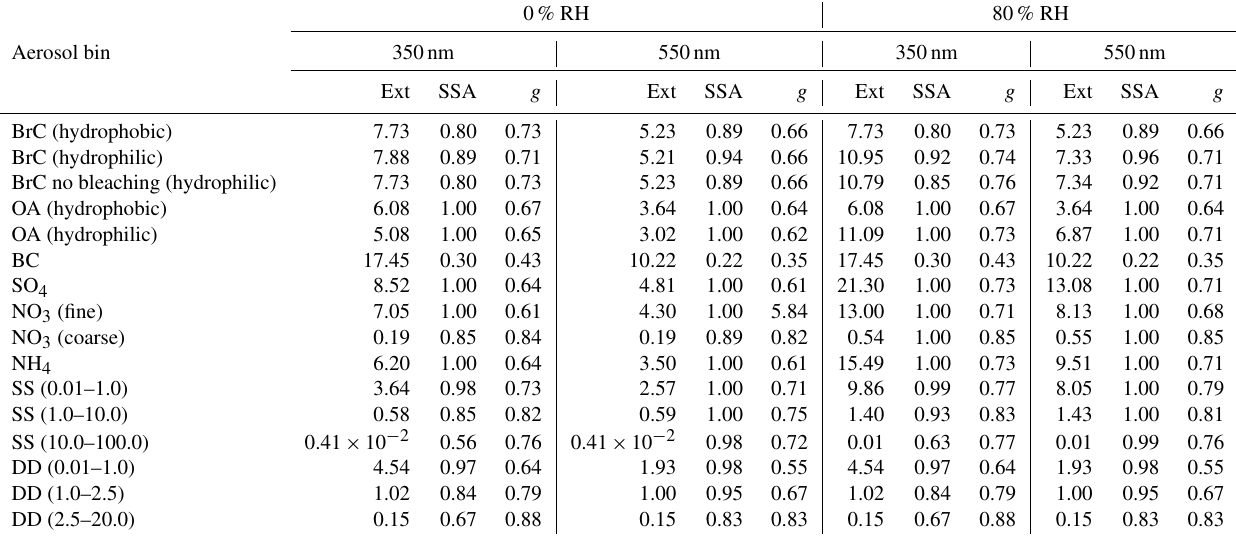
Table A1. Aerosol optical properties, namely, extinction cross section (Ext in m 2 g − 1 ), single-scattering albedo (SSA), and asymmetry parameter ( g ) used in the present version of TACTIC at 350 and 550nm. Values are given for relative humidities of 0% and 80%. Bin diameter limits (µm) are given in parentheses for SS and DD aerosols.